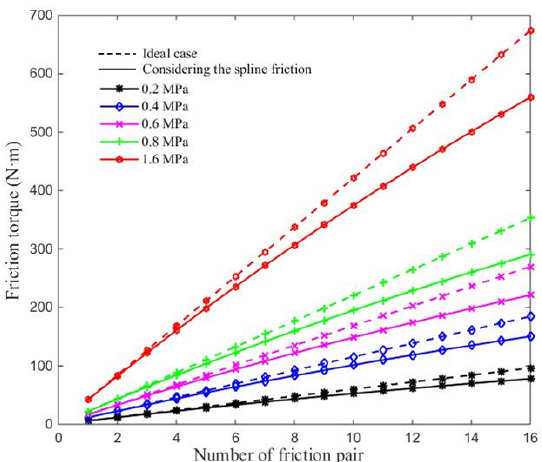
Figure 8. Variation of the friction torque.